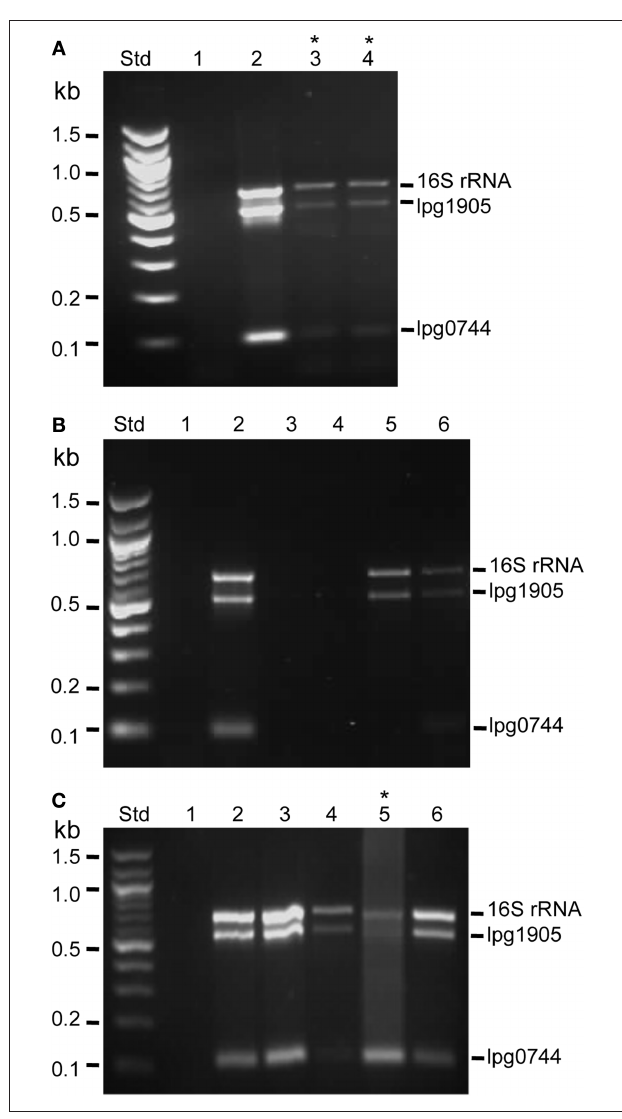
Figure 2 | Detection of lpg1905 , lpg0774, and 16SrrNA in environmental and clinical samples by multiplex PCr. (A) Detection of Legionella spp. in cooling towers at an office building. Std, 100 base pair marker (Promega); Lane 1, negative control (no DNA); Lane 2, L. pneumophila serogroup 1 strain 02/41; Lane 3, Cooling tower 1; Lane 4, Cooling tower 2. (B) Detection of Legionella spp. in cooling tower and shower head water samples collected from a hotel. Std, 100 base pair marker (Promega); Lane 1, negative control (no DNA); Lane 2, L. pneumophila serogroup 1 strain 02/41; Lane 3, Cooling tower surface water; Lane 4, Cooling tower sediment; Lane 5, Shower head 915; Lane 6, Shower head 1617. (C) Detection of Legionella spp. in patient samples. Std, 100 base pair marker (Promega); Lane 1, negative control (no DNA); Lane 2, L. pneumophila serogroup 1 strain 02/41; Lane 3, Sputum spiked with L. pneumophila serogroup 1 strain 02/41; Lane 4, Patient 1 (male, 22 years old), sputum sample; Lane 5, Patient 2 (male, 70 years old),